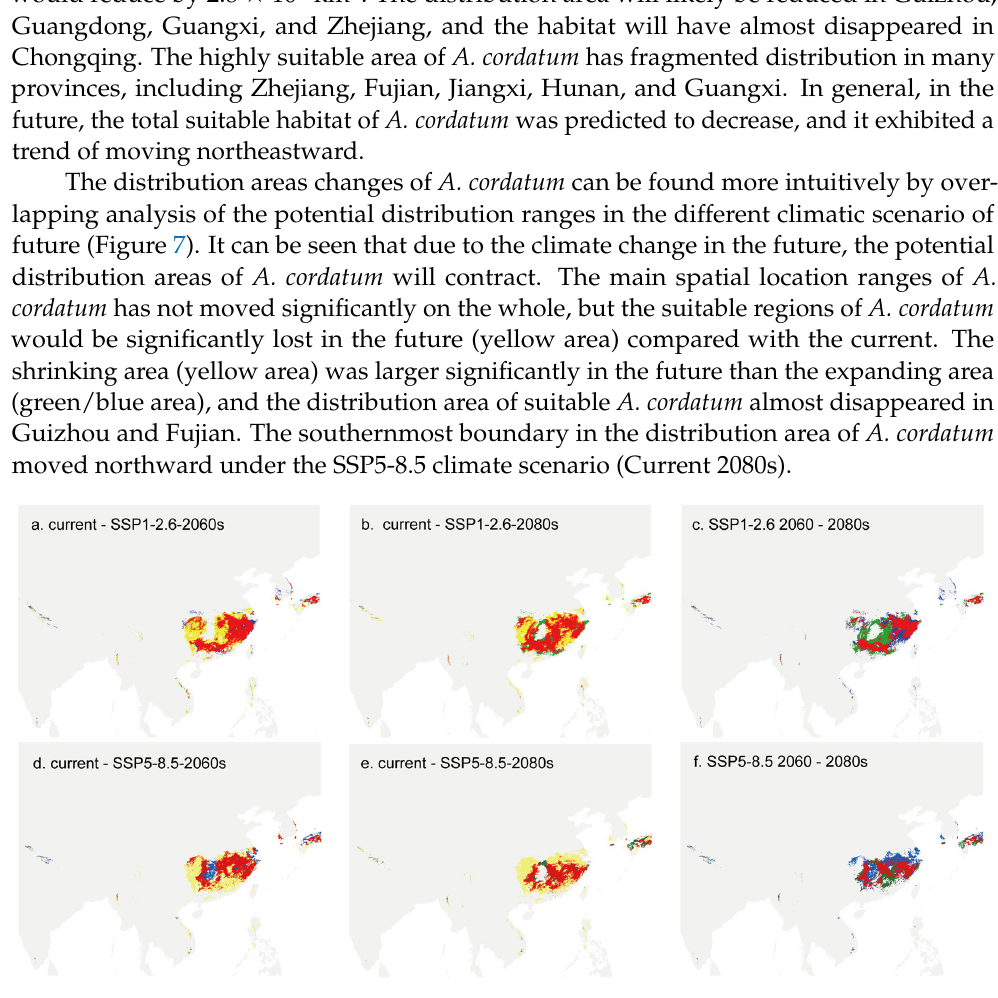
Figure 7. Distribution area changes of A. cordatum in the future under SSP1-2.6 and SSP5-8.5 climatic scenarios. ( a – c ) The distribution areas of A. cordatum in current to 2060s, current to 2080s, and 2060s to 2080s under SSP1-2.6 climatic scenarios. ( d – f ) The distribution areas of A. cordatum in current to 2060s, current to 2080s, and 2060s to 2080s under SSP5-8.5 climatic scenarios. The red area represents the distribution area overlapped or unchanged between the two different periods. The yellow area represents the potential distribution area of current. The blue and green areas represent the potential range of expansion of 2060 and 2080 years, respectively.